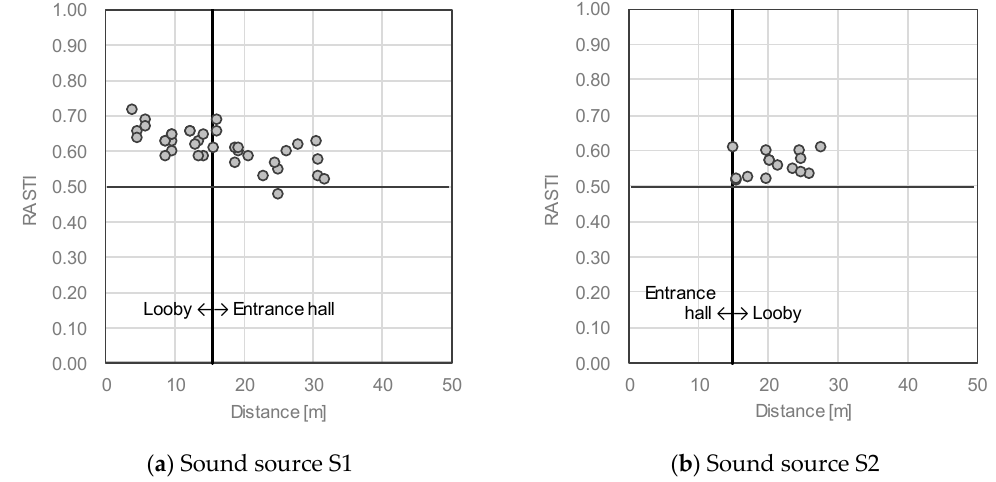
Figure 9. Relationship between the distance from the sound source and the value of RASTI: ( a ) sound source S1 and ( b ) sound source S2.